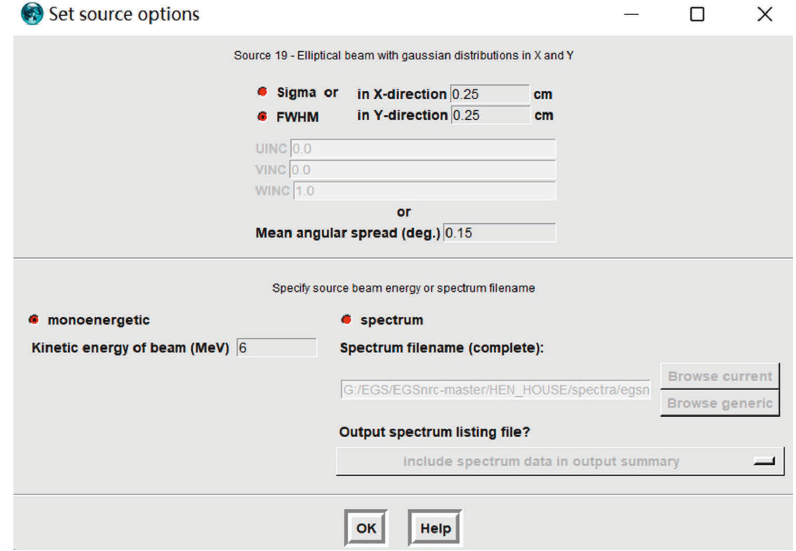
Figure 2: The Gaussian distribution source (ISOURC � 19) parameter settings in the BEAMnrc code.